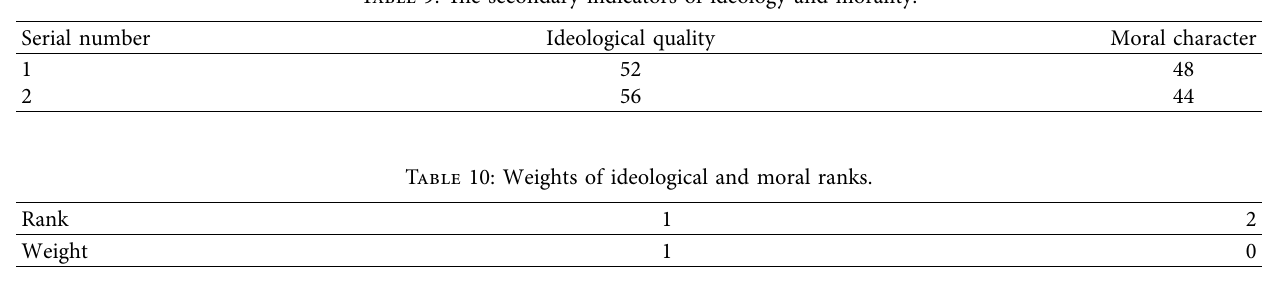
Table 9: The secondary indicators of ideology and morality.